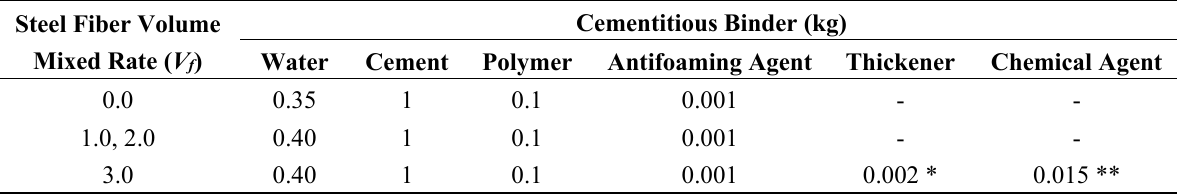
Figure 10. Steel fiber. ( a ) Steel fiber SF06 (= 6 mm); ( b ) steel fiber SF13 (= 13 mm). Table 3. Combined ratio of adhered mortar mixed with steel